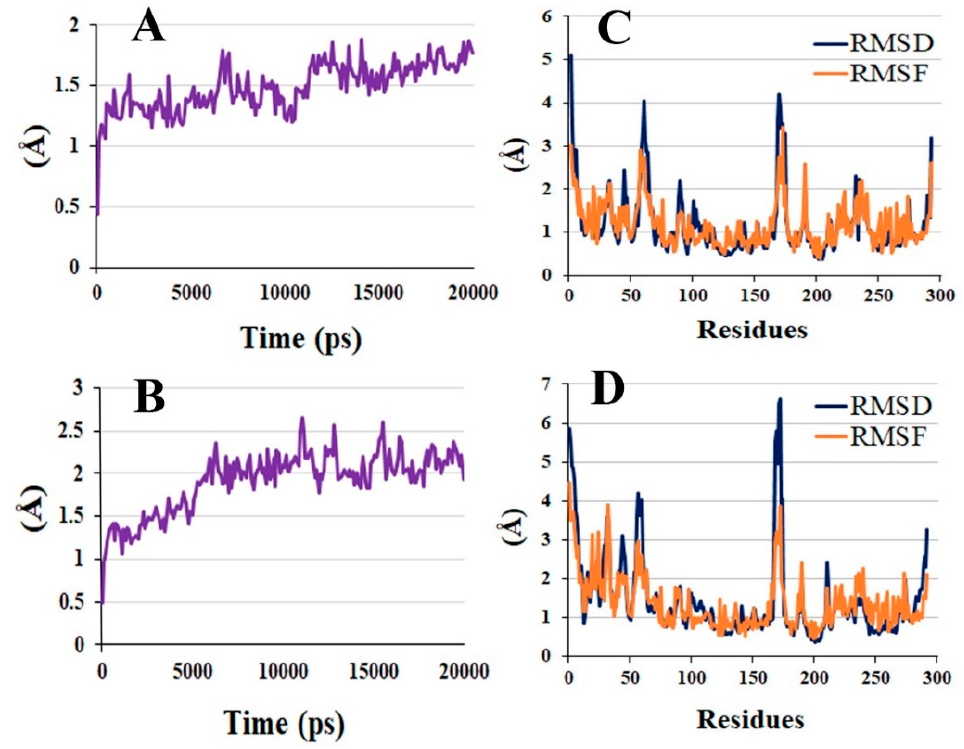
Figure 5. The time series of root mean square deviations of backbone atoms for DEB and FRA complex ( A , B ). Structural modification of protein by means of root mean square deviations (RMSD) and root mean square fluctuations (RMSF) for DEB and FRA complex ( C , D ).